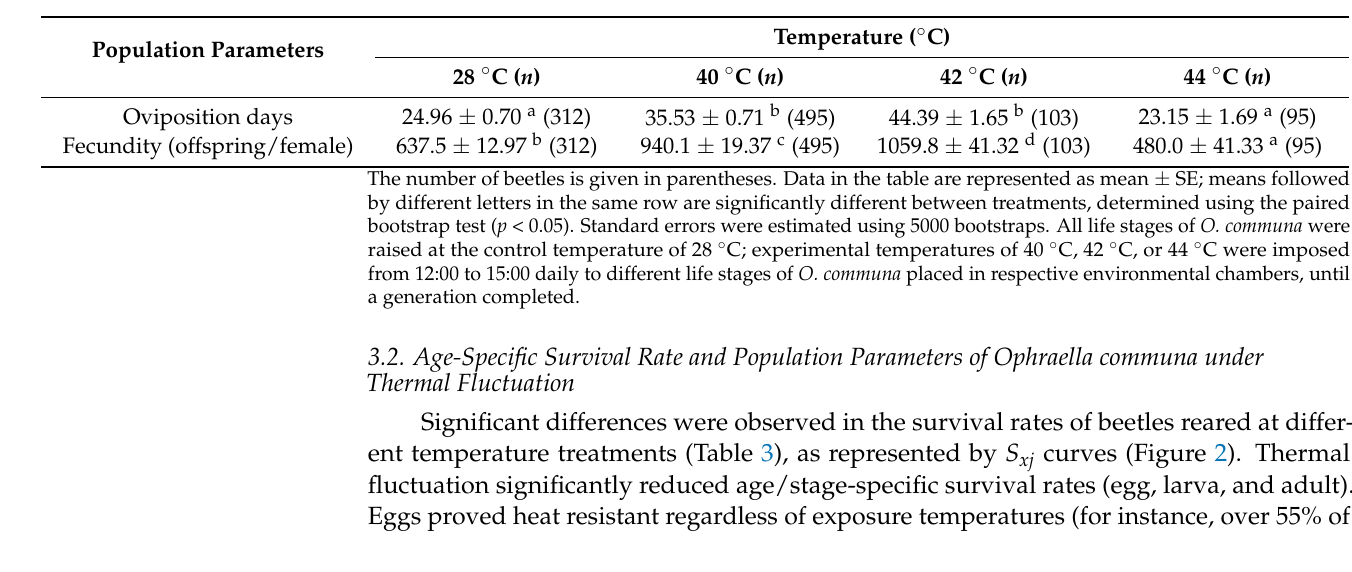
Table 2. Effects of periodical high-temperature exposure on the fecundity of adult ragweed beetle Ophraella communa